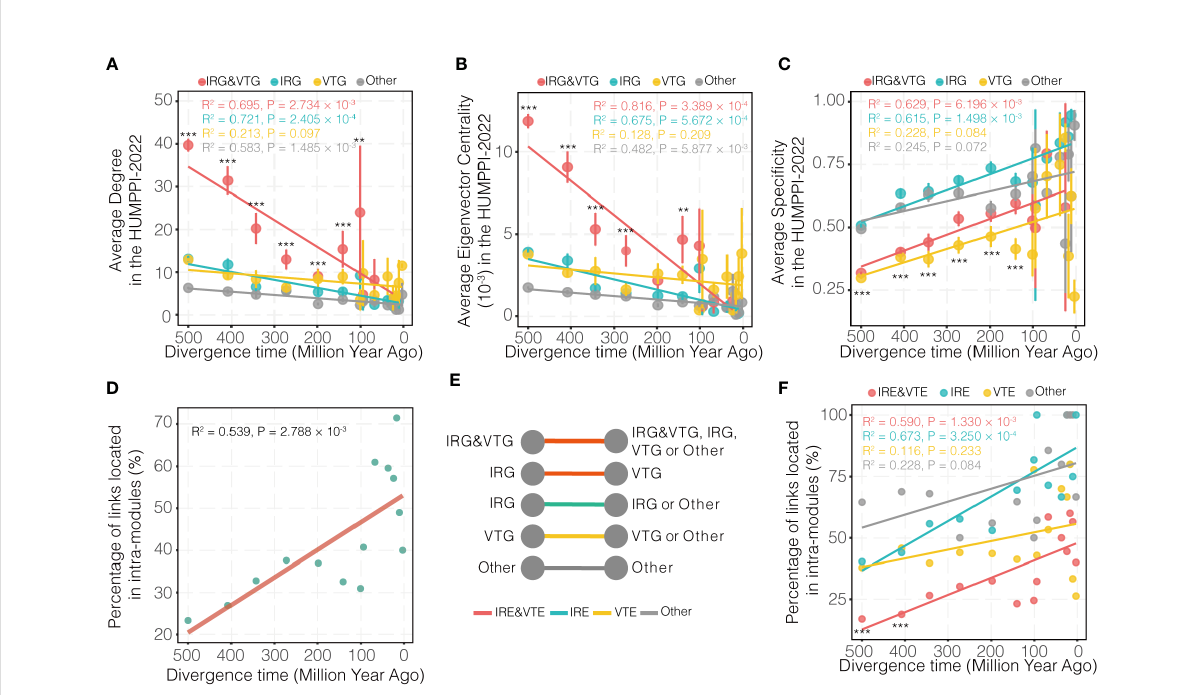
FIGURE 4 Evolutionary pattern of genes and edges related to their divergence times. (A – C) Distribution of PPI network degree, eigenvector centrality and tissue expression speci fi city for four categories of genes from different phylogenetic branches. Virally-targeted immune-related genes (IRG&VTGs), immune-related genes (IRGs), Virally-targeted genes (VTGs) and other genes (Others) are highlighted in red, cyan, yellow and grey, respectively. (D) Evolutionary pattern of edges related to their divergence times. (E) Schematic diagram of four categories of edges. Virally- targeted immune-related edges (IRE&VTEs), immune-related edges (IREs), virally-targeted edges (VTEs) and other edges (Others) are highlighted in red, cyan, yellow and grey, respectively. (F) Evolutionary pattern of four categories of edges related to their divergence times. IRE&VTEs, IREs, VTEs and Others are highlighted in red, cyan, yellow and grey, respectively. The divergence time of each gene age group is assigned as the middle time point for each branch. The oldest branch (branch 0) is arbitrarily set as 500 Mya. *** P -value < 0.001, ** P -value <